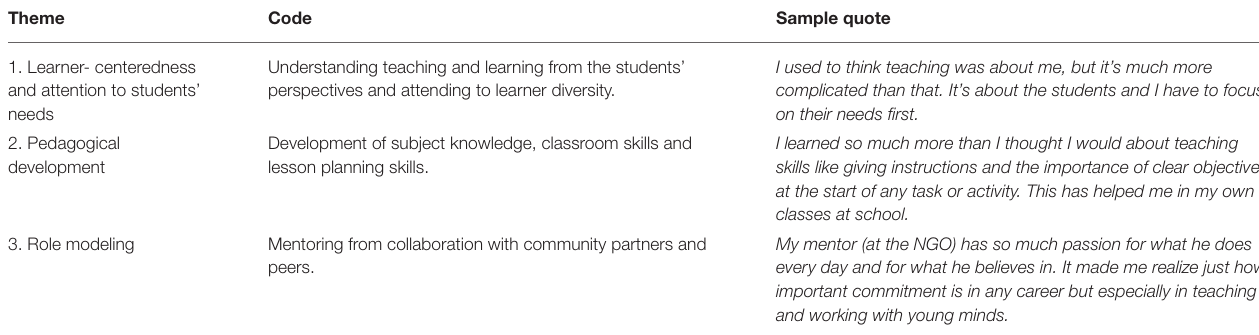
TABLE 2 | Overview of themes and codes.